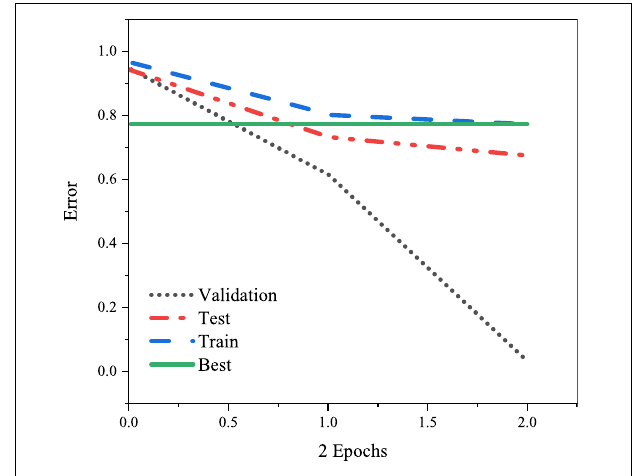
FIGURE 6 | Training results of entrepreneurship education based on